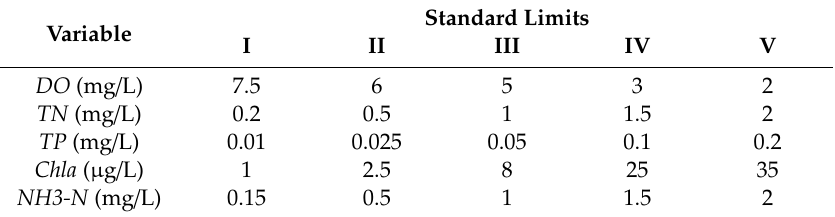
Table 1. Standard limits of water quality variables.